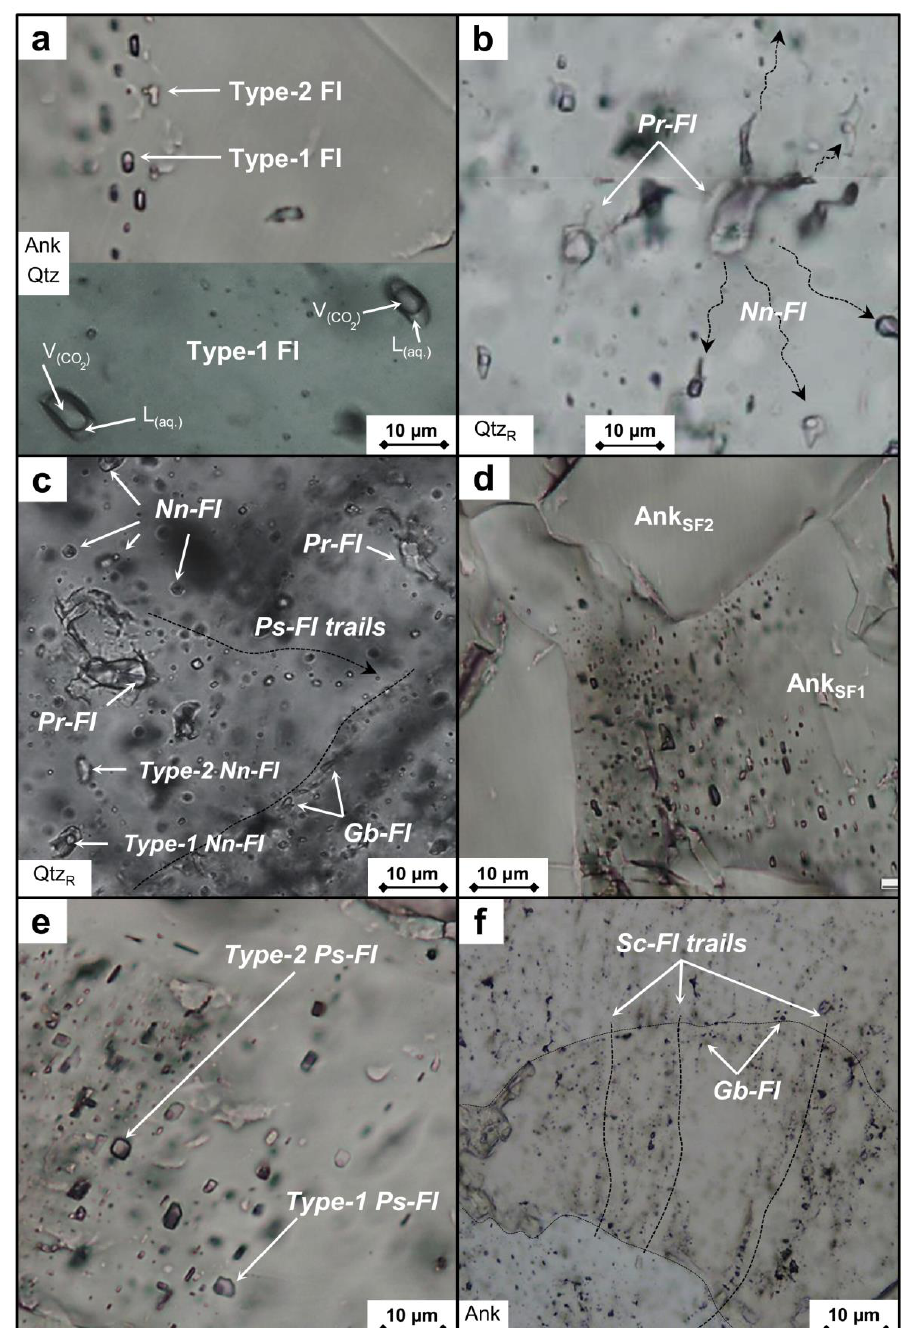
(Figure 9). Final homogenization (Th) took place by vapor disappearance for FI of both Type-1 and Type-2, between 135 ◦ C and 275 ◦ C (Table 2; Figure 9b). The Th distribution pattern shows two clusters: one, from 135 ◦ C to 190 ◦ C, which consists mostly of Ps-, Gb-, and Sc-FI, and a second around 250 ± 30 ◦ C, consisting mostly of Pr-FI (Figure 9b).